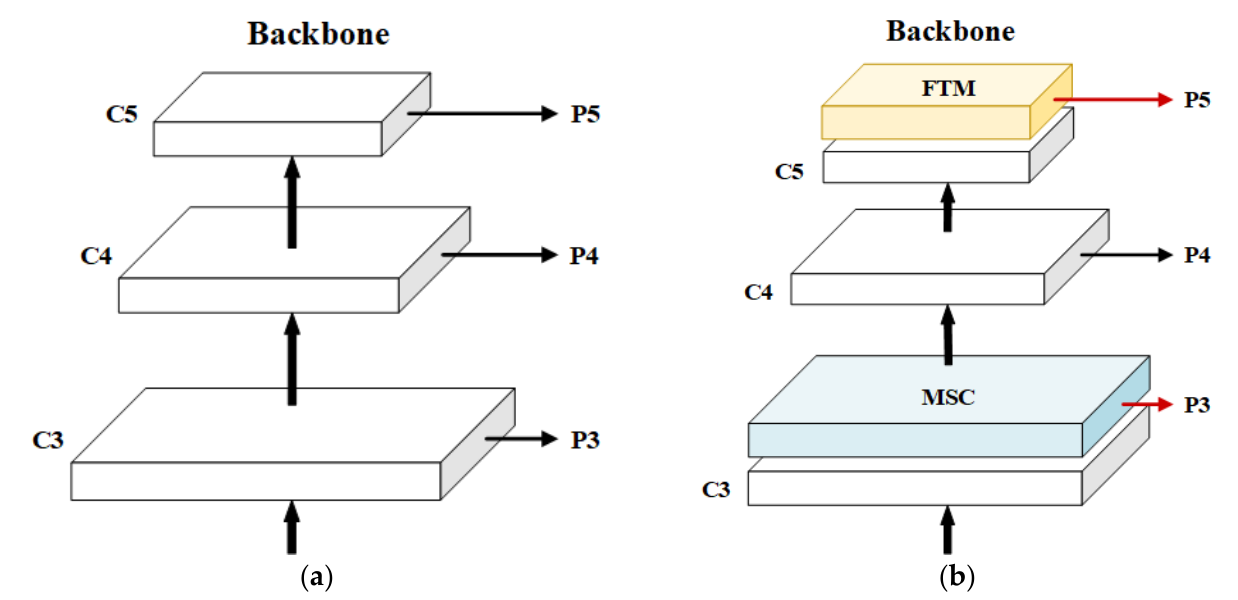
Figure 2. Comparison of partial model structure: ( a ) YOLOX. ( b ) YOLO-SD.